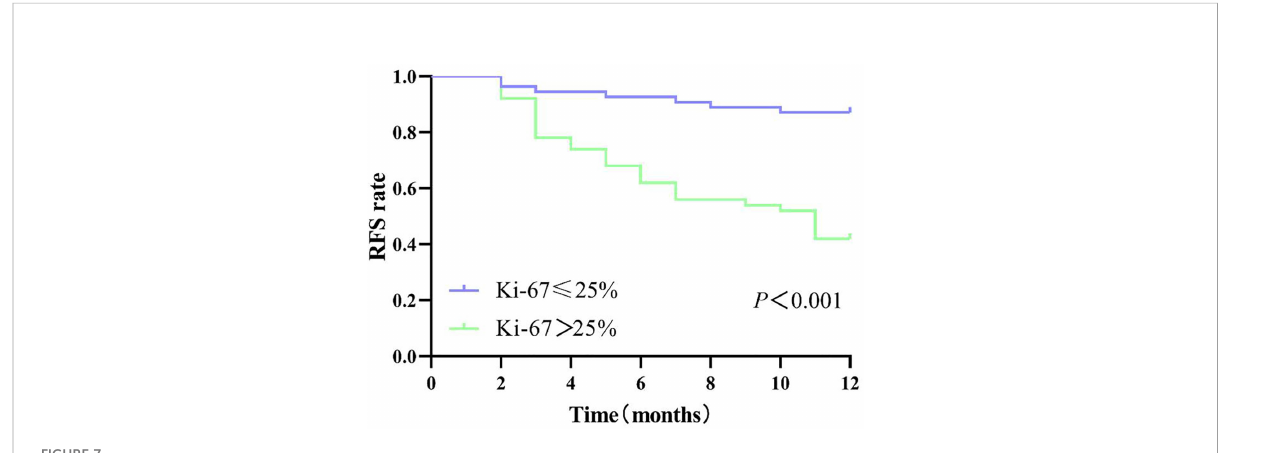
FIGURE 7 Disease-free survival of patients with high Ki-67 expression and low Ki-67